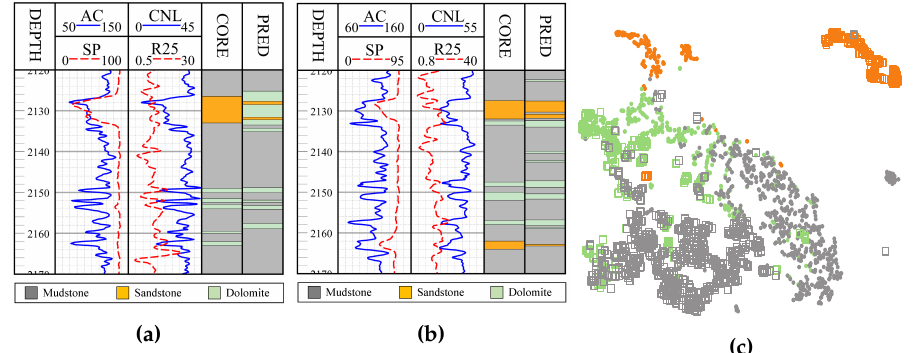
Figure 1. Illustration of data drift ( a ): Logging curves, core, and prediction results (using the model trained on well W b ) on well W a . ( b ) Logging curves, core, and prediction results (using the model trained on W a ) of W b . ( c ) t-SNE [25] visualization of data distribution for W a and W b . Gray, yellow, and green indicate mudstone, sandstone, and dolomite, respectively. Point and hollow square indicate data from W a and W b , respectively. W a and W b are geospatially